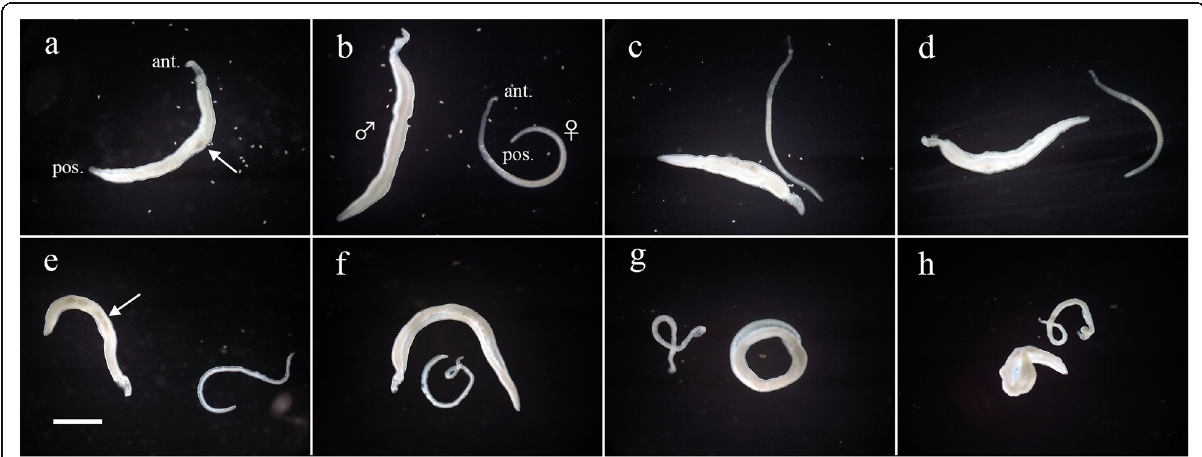
Fig. 1 Effect of febrifugine on the gross morphological alteration of Schistosoma mansoni adult worms. Paired S . mansoni adult worms were continuously incubated in media alone for 3 ( a ), 5 ( b ), 7 ( c ), and 8 ( d ) days (control group), while paired adult worms were incubated with 0.5 μ g/ml febrifugine for 3 ( e ), 5 ( f ), 7 ( g ), and 8 ( h ) days. Arrows indicate the localization of black contents. The symbols ♂ and ♀ indicate male and female worms, respectively. ant . anterior part of body, pos . posterior part of body. Scale bar = 1 mm